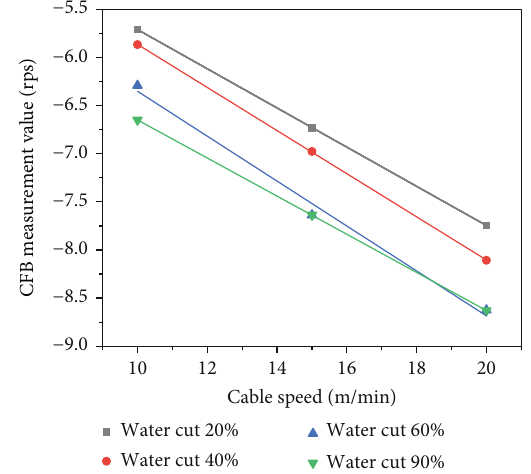
Figure 9: Relational graph of the measured value of 93 ° inclination of 600 m 3 /d CFB and cable speed.